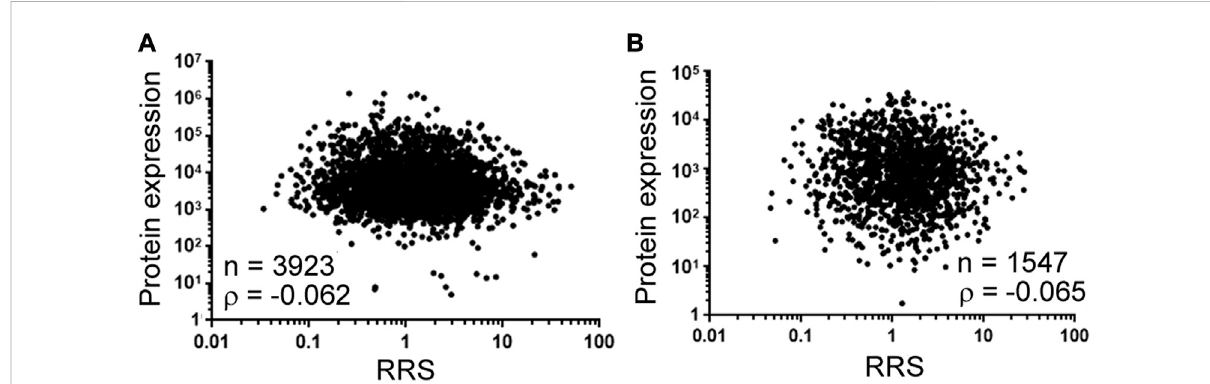
FIGURE 2 Ribosome recruitment (RRS) and protein expression in yeast. (A) Spearman correlation analysis between RRS [the x -axis, according to dataset GSE182290 (Niederer et al., 2022)] and protein expression (the y -axis) from Supplementary Table S4 in (Ho et al., 2018). Dots represent individual genes(mRNAs andthecorrespondingproteins).FormRNAswithisoforms,weaddedtheirRRSpriorto correlationanalysis.Numberofgenes(n)and thecorrelationcoef fi cient( ρ )areshownonthegraph.CorrespondingtothedataofSupplementaryTableS3. (B) Spearmancorrelationbetween RRS (the x -axis) (Niederer et al., 2022) and protein expression (the y -axis) from Supplementary Table S4 in (Lahtvee et al., 2017). Labeling and descriptions see (A) . Corresponding to the data of Supplementary Table